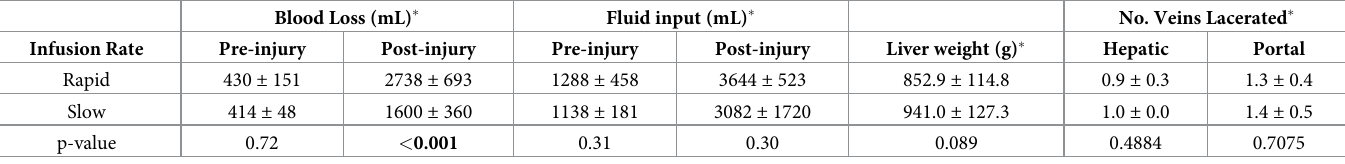
Table 1. Blood loss, fluid input, liver weight, and lacerated veins.